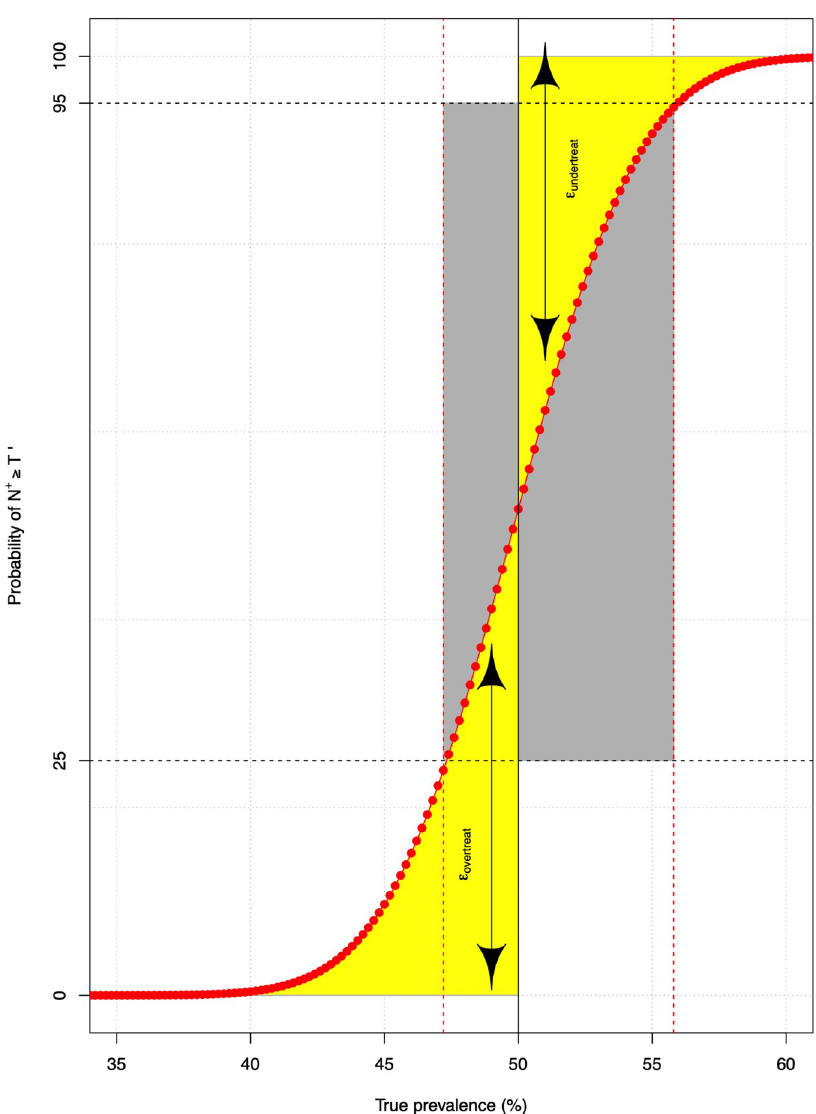
Fig 1. The general framework to determine the required sensitivity and specificity. The red line represents the subjects (= 500) being at least probability (in %) of the number of positive test results ( N + ) in a random sample of N tot T 0 (see Eq 3 ) based on an imperfect diagnostic test D (sensitivity ( Se d ) = specificity ( Sp d ) = 80%) over a wide range of ). The vertical straight line represents the program decision threshold T of 50%. true underlying prevalence ( Prev true The yellow areas highlight the program errors ε ( Prev < 50%) and ε ( Prev � 50%). The horizontal overtreat true undertreat true black dashed lines represent a ε overtreat equal to 25% and a ε undertreat equal to 5% (= 100% - 95%), the vertical red dashed lines indicate the corresponding Prev . The grey zone indicates the range of Prev for which the diagnostic true true test is considered inadequate to make a well-informed program decision ( ε overtreat > 25% and ε undertreat > 50%).